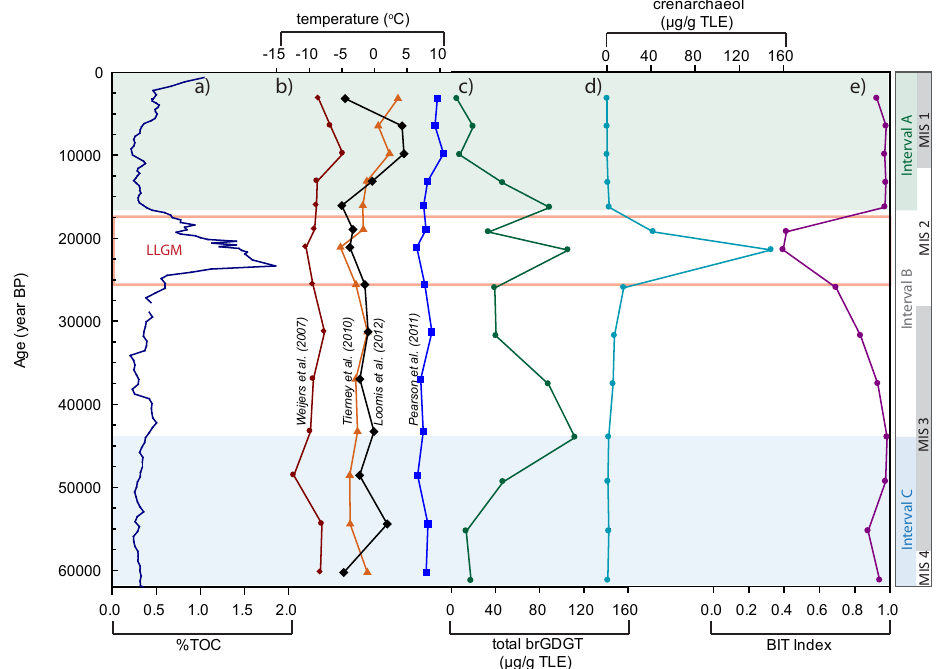
Fig. 5. Branched and isoprenoid GDGTs in Lake El’gygytgyn. The interval of the LLGM is highlighted. (a) %TOC (Murdock et al., 2012), (b) MBT/CBT-derived temperatures applying the calibrations of Weijers et al. (2007; red circles), Tierney et al. (2010a; orange triangles), Loomis et al. (2012; black diamonds) and Pearson et al. (2011; blue squares). Note that the fractional abundance calibration of Tierney et al. (2010) and the stepwise forward selection calibration of Loomis et al. (2012) were applied. (c) Total branched GDGTs concentrations, (d) concentrations of the isoprenoid GDGT crenarchaeol, and (e) BIT index values. The orange box denotes LLGM.